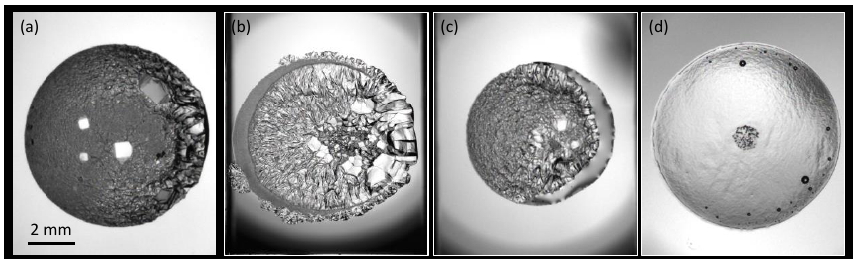
Figure 11. Methane hydrate formed from various aqueous systems subject to a temperature gradient ( a ) Water + Methane system T L = 273.7 K (left) to T H = 277.7 K (right), p = 4.00 MPa ( b ) Water + Methane + MEG system, T L = 275.0 K (left) to T H = 279.0 K (right). w MEG = 10%, p = 5.99 MPa ( c ) Water + Methane + NaCl system, T L = 274.4 K (left) to T H = 278.4 K (right). w NaCl = 5.44%, p = 5.39 MPa ( d ) Water + Methane + PVP system, T L = 273.7 K (left) to T H = 277.7 K (right). w PVP = 0.1%, p = 6.13